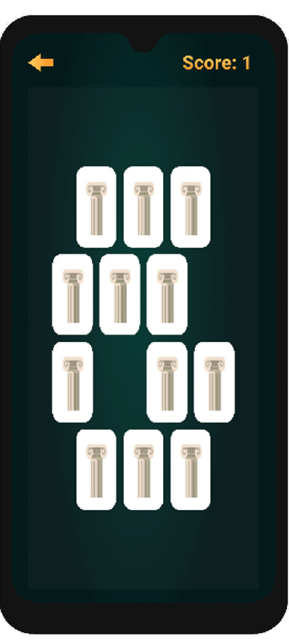
Figure 7. The icons disappear after the correct matching.